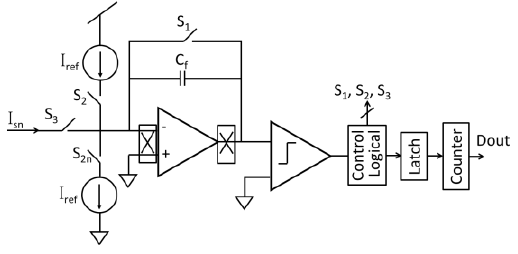
Figure 15. Dual-slope multiplying ADC architecture (adapted from [94]).